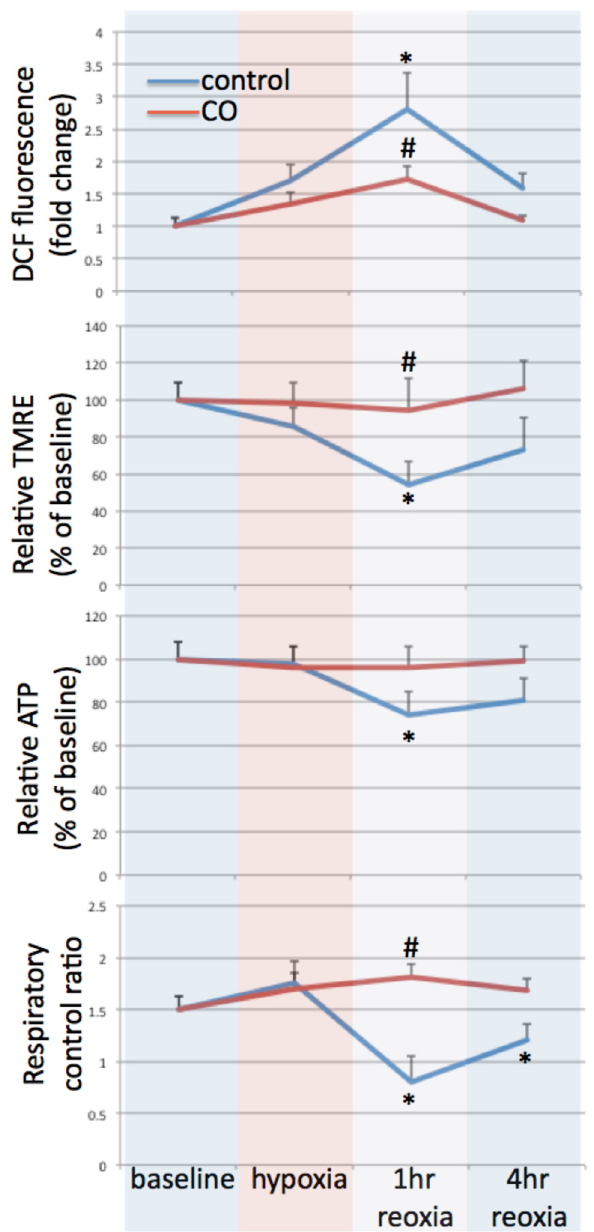
Fig 8. CO limits hypoxia-induced oxidant and mitochondrial injury in murine skeletal muscle ex-vivo. Murine skeletal muscle was freshly collected from mice after perfusion with cold PBS, cut into strips (2 X 2 X 10mm) and exposed ex vivo to hypoxia (1% O 2 ) for one hour followed by reoxia for up to 4 hours. Some samples were treated with CO (250 ppm) during hypoxia. Measurements of ROS by DCF fluorescence, relative mitochondrial membrane potential by TMRE fluorescence, relative ATP levels, and respiratory control ratio (RCR) were determined at baseline, end of hypoxia, 1 and 4 hours. Hypoxia induced increased DCF fluorescence and a drop in mitochondrial membrane potential; however statistically significant differences in these parameters, as well as reductions in ATP and RCR were not seen until after reoxygenation ( * P < 0.05 compared to baseline). All parameters had returned to or were trending back to baseline by 4 hours after reoxia. CO treatment limited these hypoxia/reoxia-induced changes (#P < 0.05 compared to hypoxia+1 hour reoxia). Each experiment was performed in duplicate and repeated three times. T-tests were used for the above comparisons.